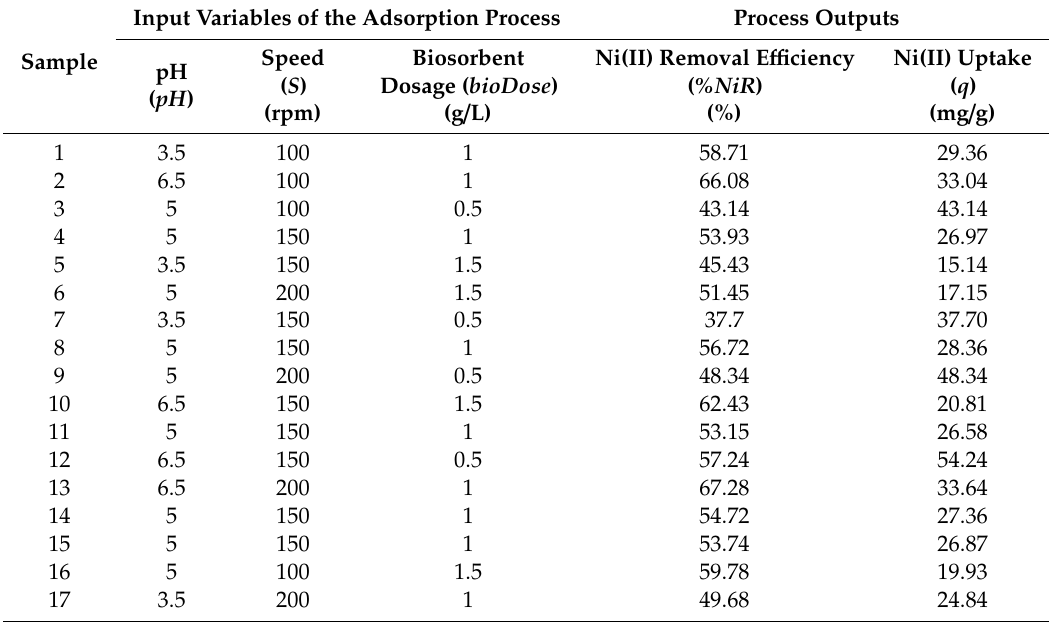
Table 3. Design matrix and process output results for the nickel adsorption